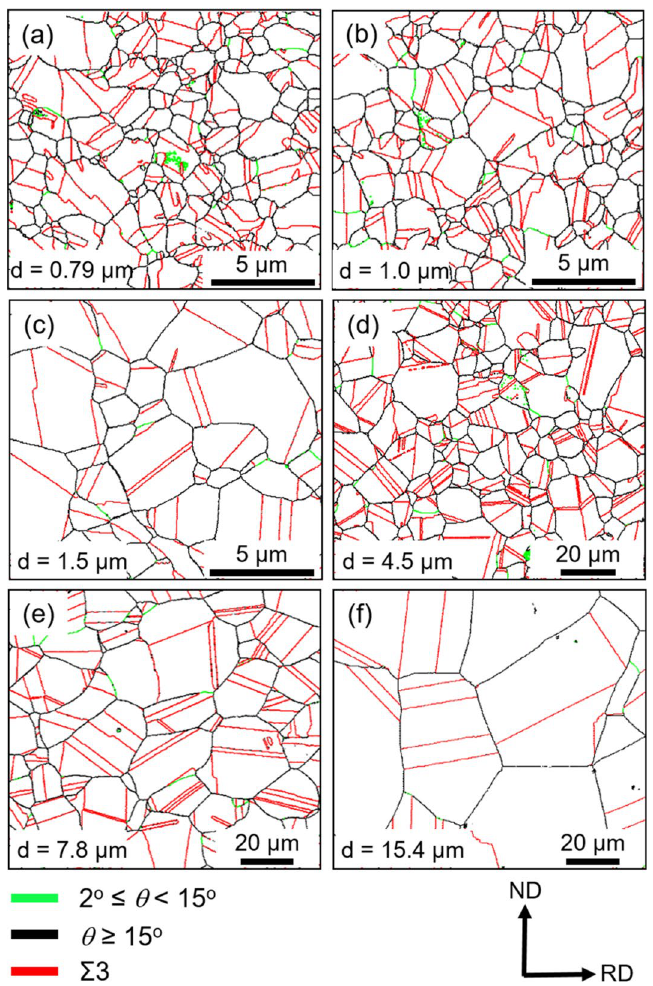
Figure 1. EBSD grain boundary maps of the specimens fabricated by the cold-rolling and subsequent annealing process: ( a ) Annealed at 700 °C for 300 s, ( b ) 750 °C, 300 s, ( c ) 800 °C, 300 s, ( d ) 900 °C, 300 s, ( e ) 950 °C, 300 s, and ( f ) 950 °C, 900 s. The green, black and red lines represent low-angle boundaries, high-angle boundaries and Σ3 twin boundaries, respectively. The high-angle boundaries were determined as boundaries with misorientations (θ) larger than 15° (15° ≤ θ), and low-angle boundaries with misorientations between 2° and 15° (2° ≤ θ < 15°), respectively. ND and RD indicate the normal direction and rolling direction of the sheets,